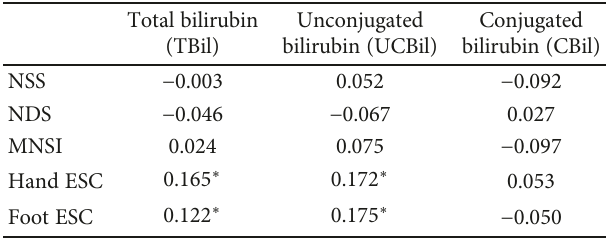
Table 3: Spearman correlation between traditional screening scores including NSS, NDS, and MNSI and hand and foot ESC level detected by the SUDOSCAN and bilirubin level (total, unconjugated, and